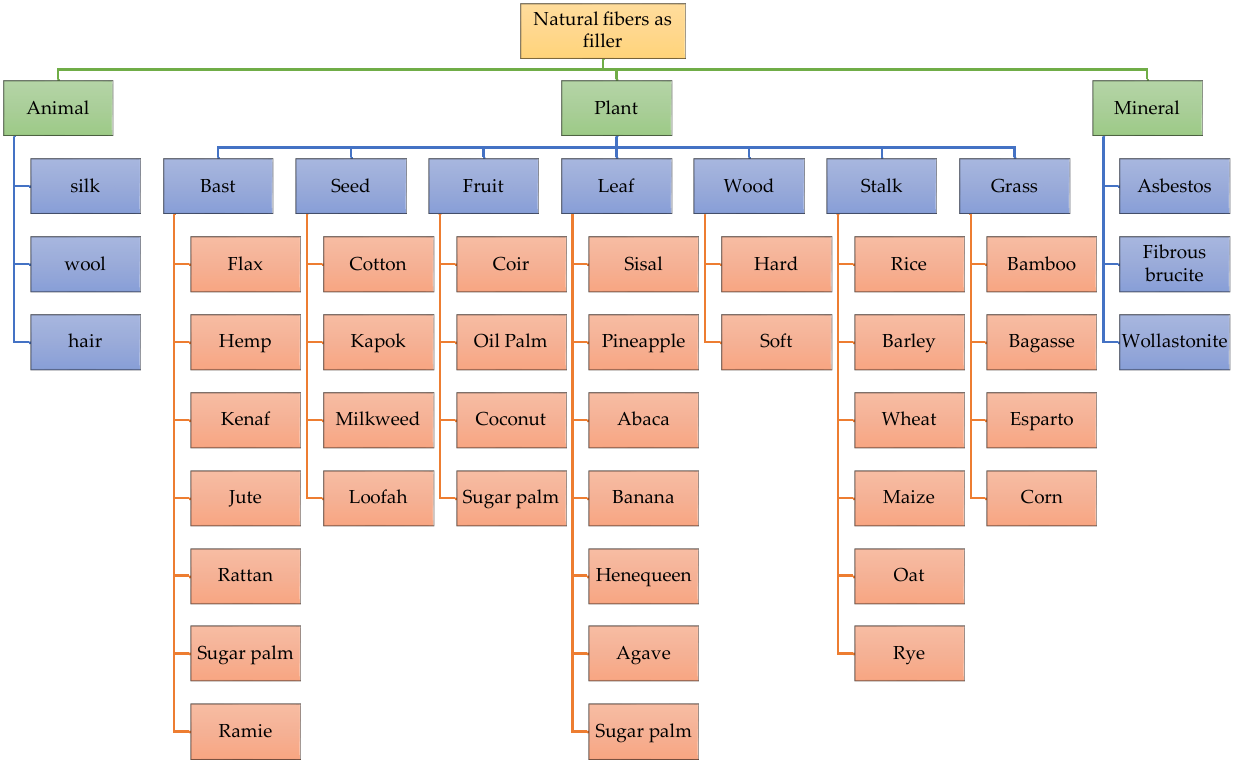
Figure 8. Classification of natural fibers as filler for polymer composites.